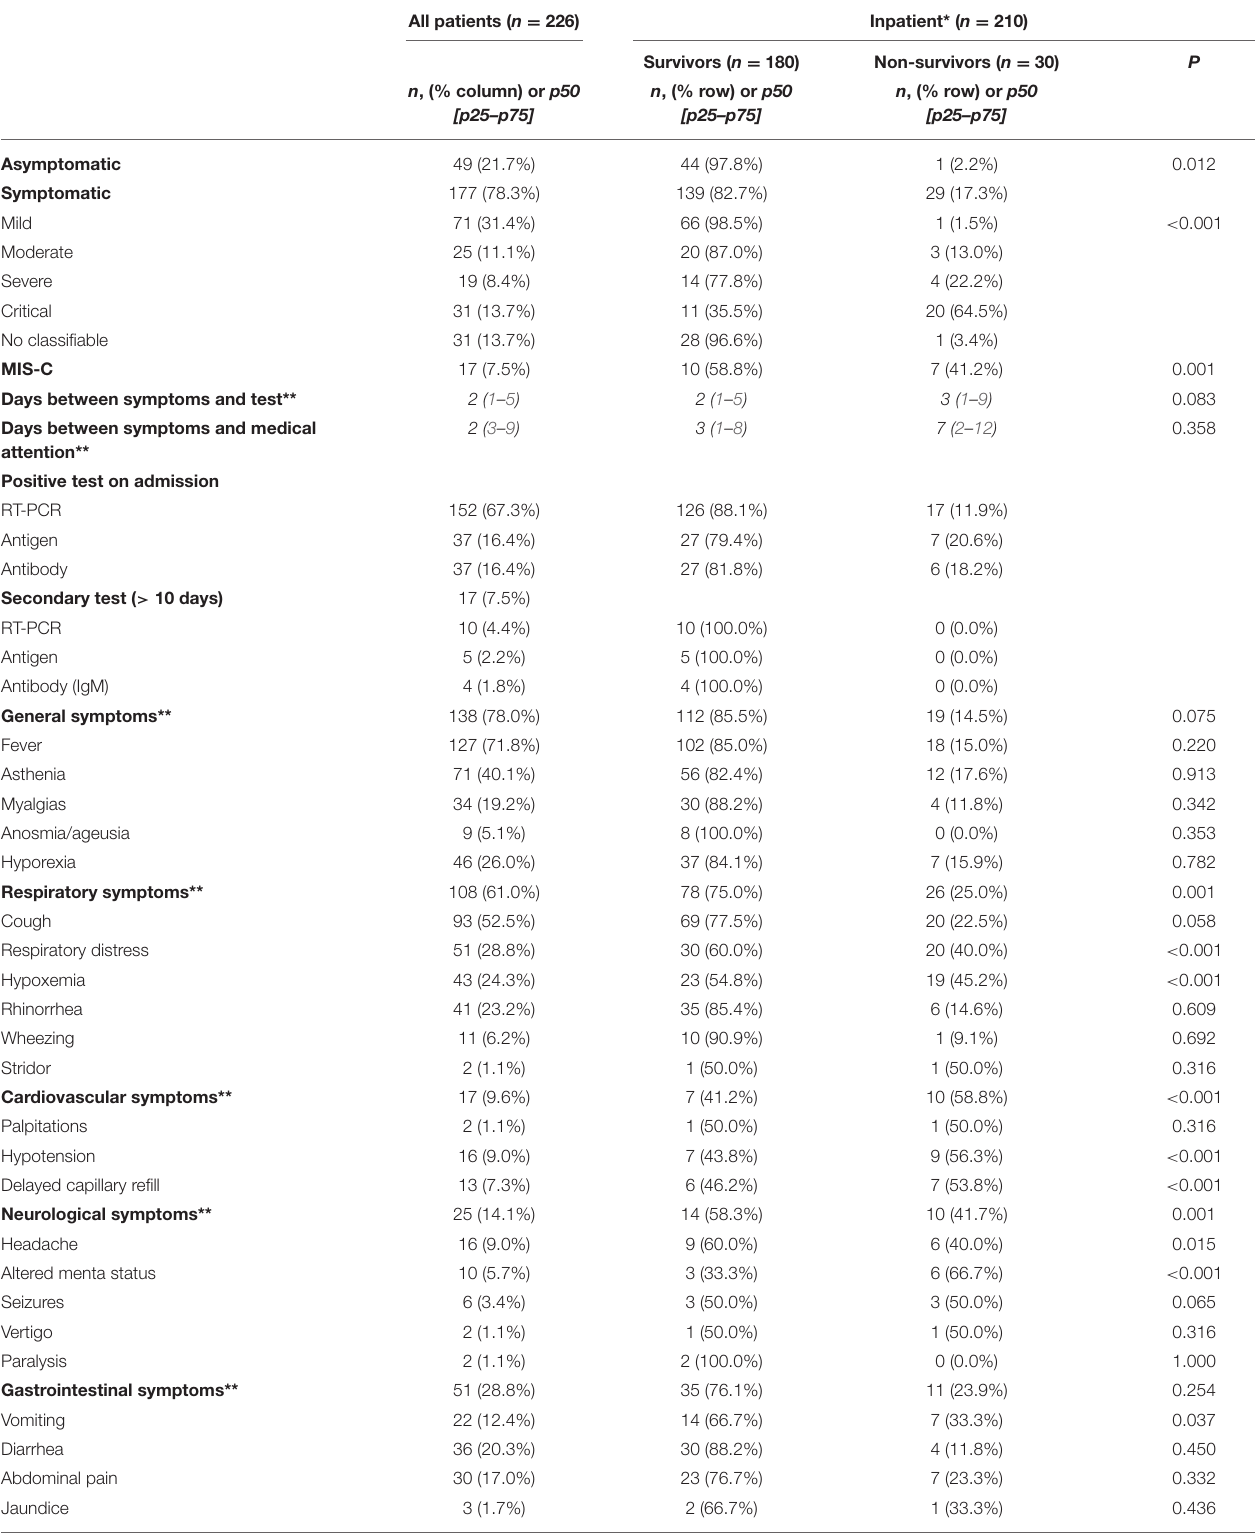
TABLE 3 | COVID-19 characteristics, diagnostic tests, and symptoms